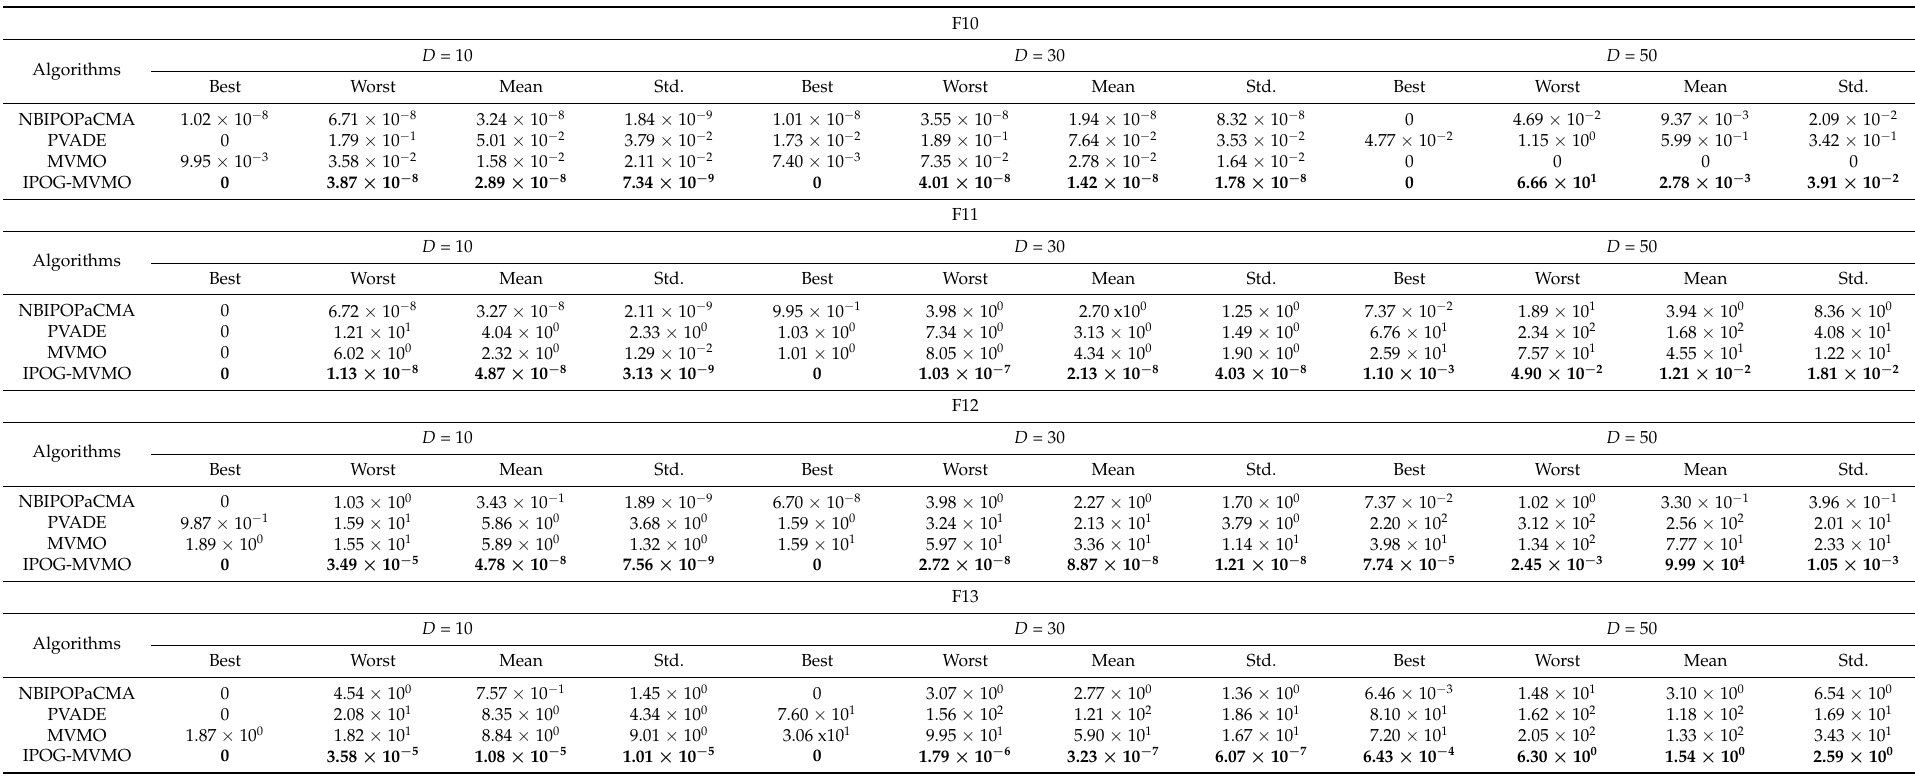
Table 4. The comparative results of the errors obtained from multimodal functions